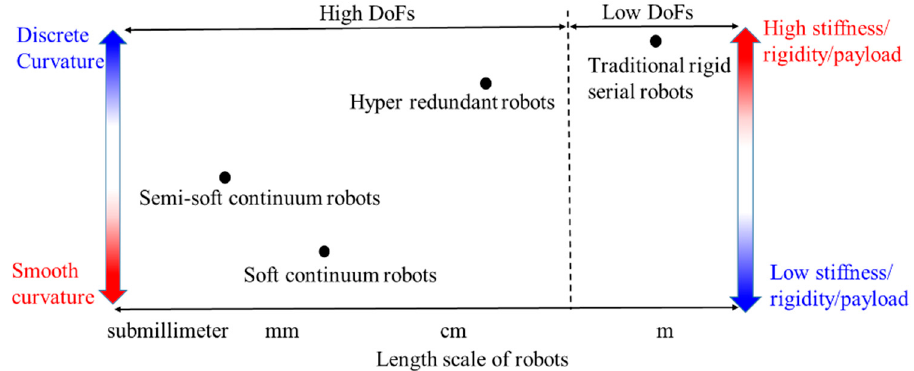
Figure 1. The comparison between CCRs and rigid serial robots.